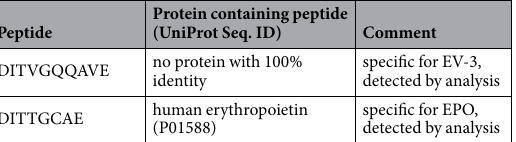
Table 1. Specificity of EV-3 and EPO “identifier” peptides. Proteolytic peptides specific for EV-3 and EPO were predicted from the amino acid sequence and used for protein identification in multiple-reaction-monitoring (nano-LC-ESI-MS/MS). Blast is used to predict for possible homologies of these peptides to other